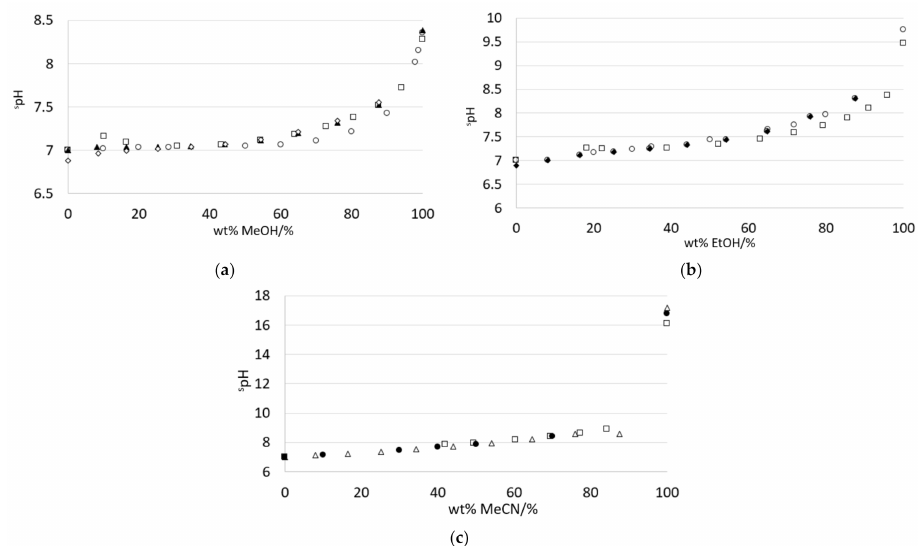
Figure 3. Theoretical s pH values for three water–solvent mixture systems: ( a ) water–methanol, ( b ) water–ethanol, and ( c ) water–acetonitrile. ( a ) water–methanol mixtures: ( culated according to [37]. ( b ) water–ethanol mixtures: ( and ( ˝ ) calculated according to [37]. ( c ) water–acetonitrile mixtures: ( ∆ ) Table 1 in [43], ( ‚ ) Table 6 in [44], and calculated according to